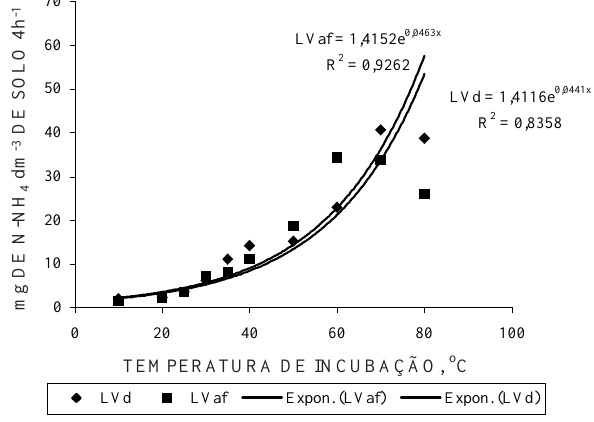
Figura 3. Velocidade de hidrólise da uréia (mg de N-HH dm -3 de solo 4 h -1 ), sob diferentes tempe- 4 raturas de incubação, em amostras de Latossolo Vermelho Aluminoférrico típico e Latossolo Vermelho distrófico típico.